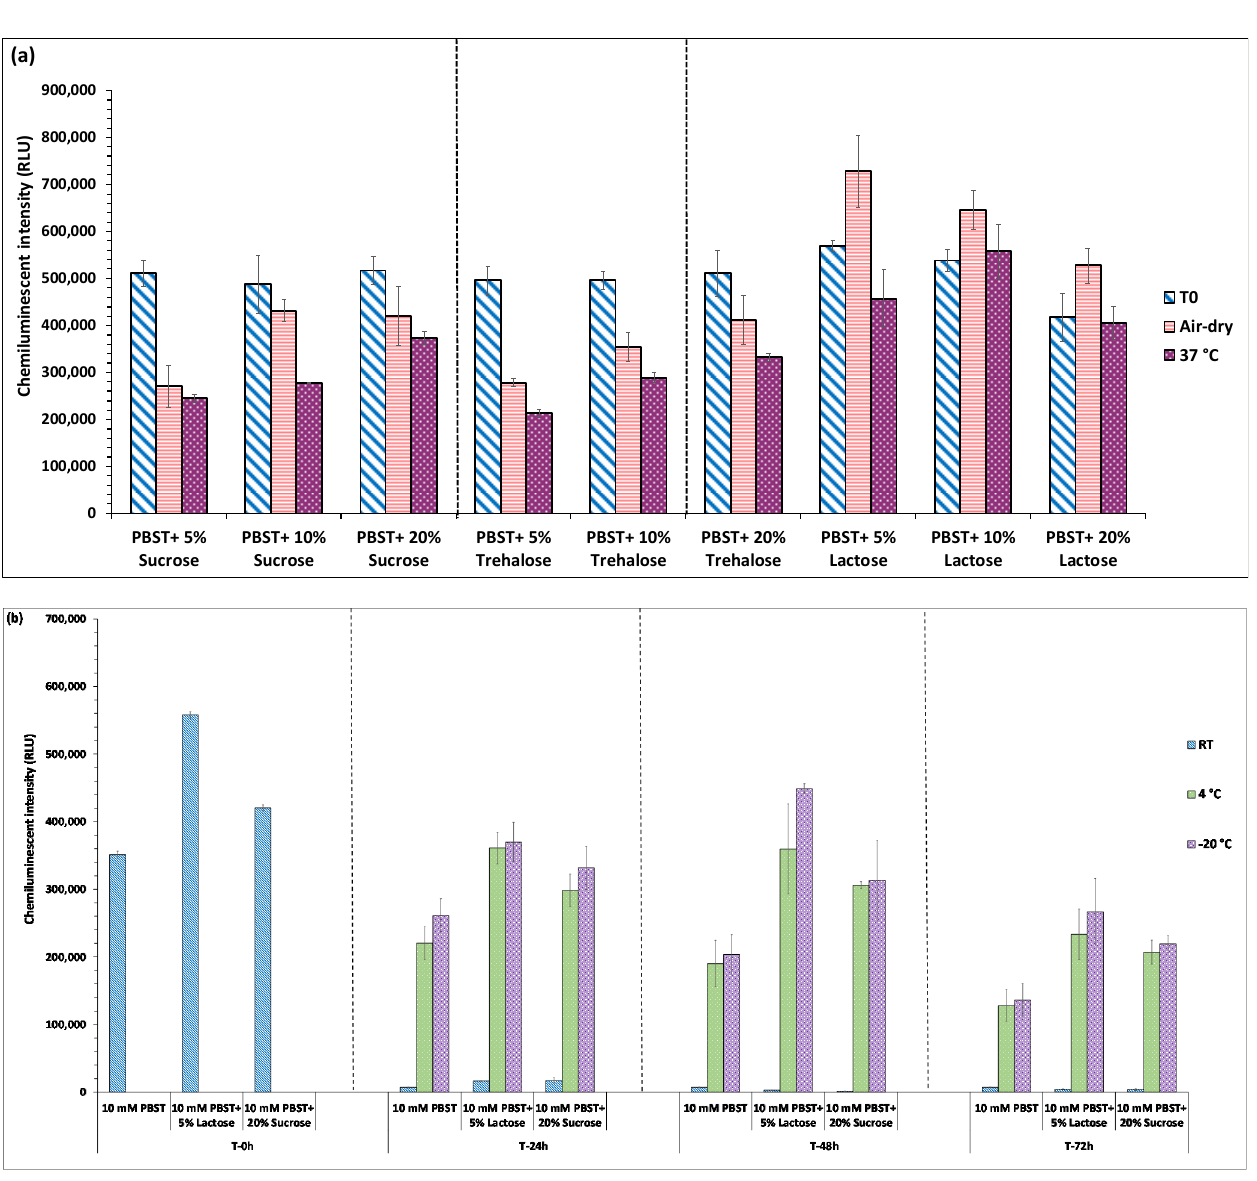
Figure 3. Impact of different types of stabilizers on the stability of conjugate pads during ( a ) drying process and ( b ) storage at different temperatures.